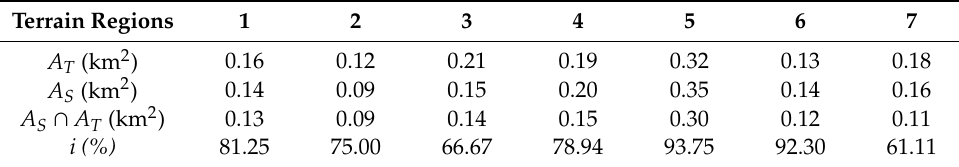
Figure 13. Results of terrain characteristic extraction from the Jijing landslide: ( a ) front view and ( b ) lateral view of slope units from the MIA-HSU method; ( c ) front view and ( d ) lateral view of slope units from the conventional method (Numbers one to seven in the slope units from MIA-HSU extraction correspond to numbers one to seven extracted from field measurement in Figure 10). Table 6. The overlap degree of area of slope unit and terrain regions in Jijing landslide.